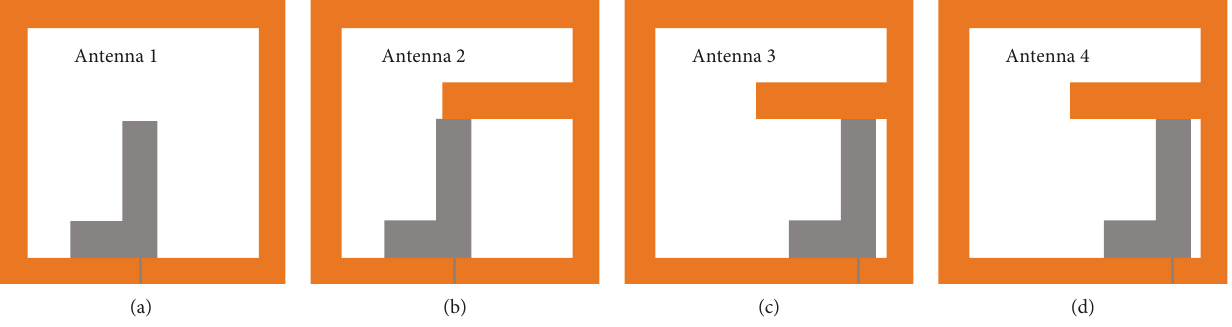
Figure 2: Evolutionary steps of the proposed antenna.